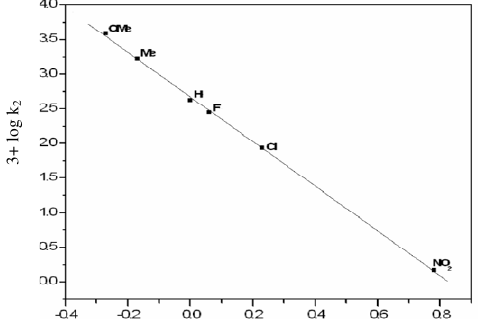
Figure 4. Hammett plot for the oxidation of ( p -substituted phenylthio)acetic acids by NBP at 298 K